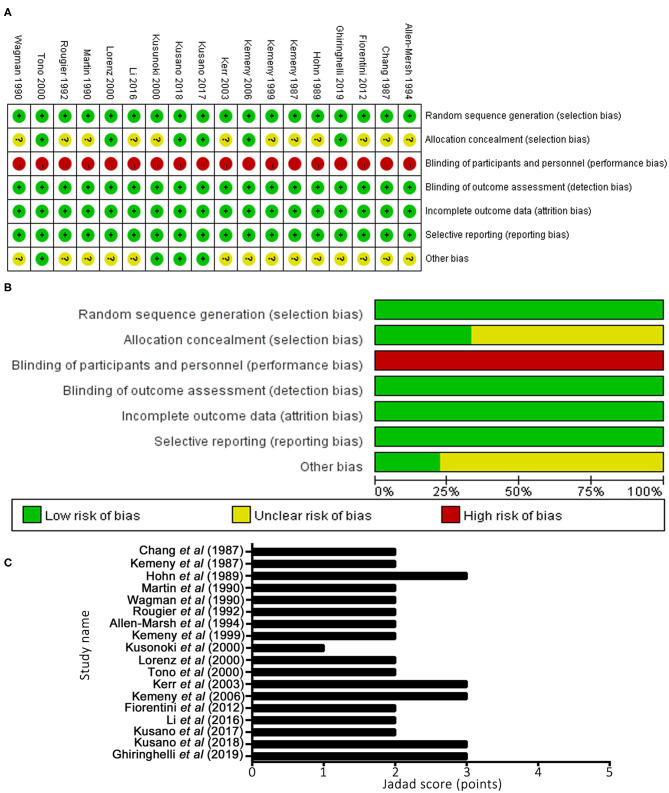
Methodological quality graph and summary of the included studies: (A) Risk of bias summary; (B) Risk of bias graph; (C) Jadad scoring system.